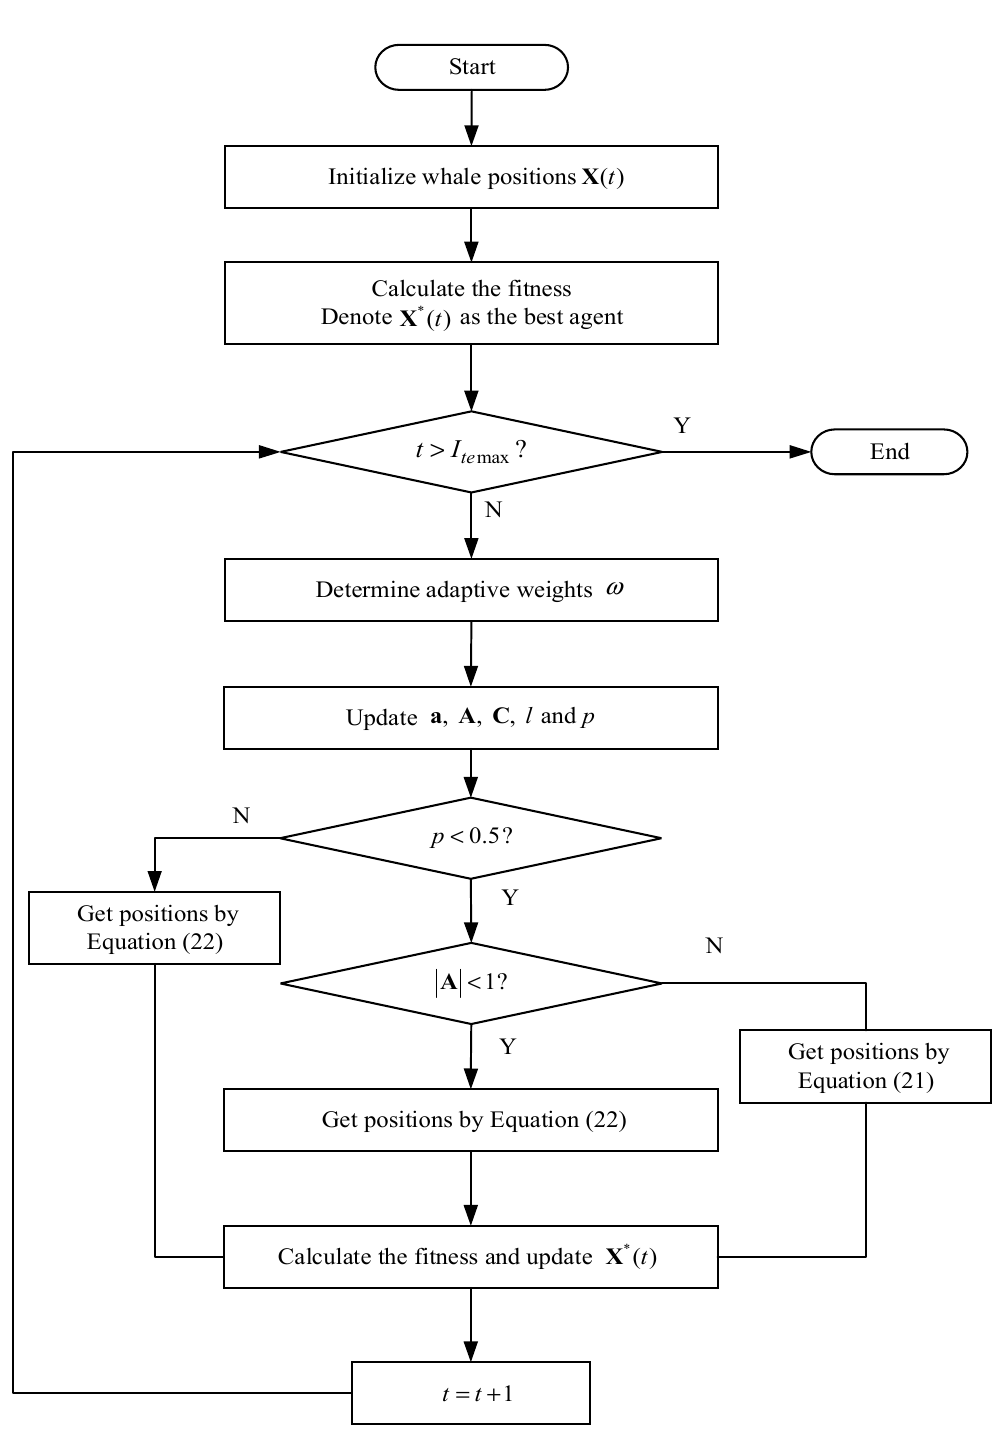
Figure 7. Flow chart of improved whale optimization algorithm (IWOA).